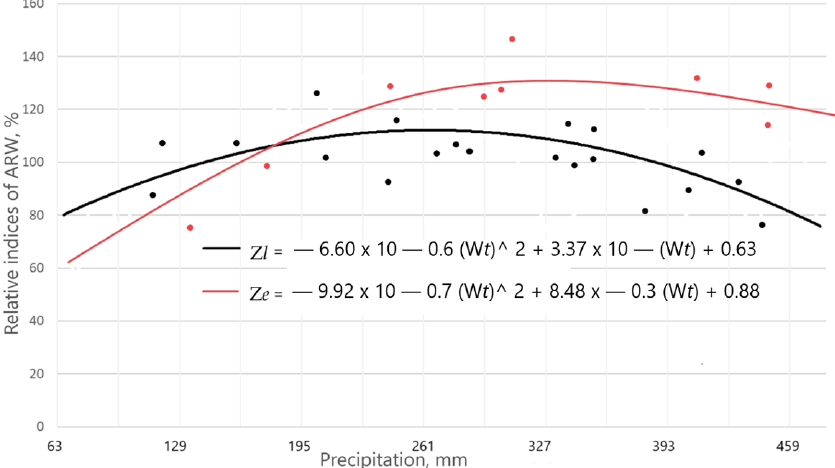
Figure 7. Relationship between ARW and summer precipitation in late (Zl) and early (Ze) forms of English oak in a dry sedge oak grove, Shipov Forest.